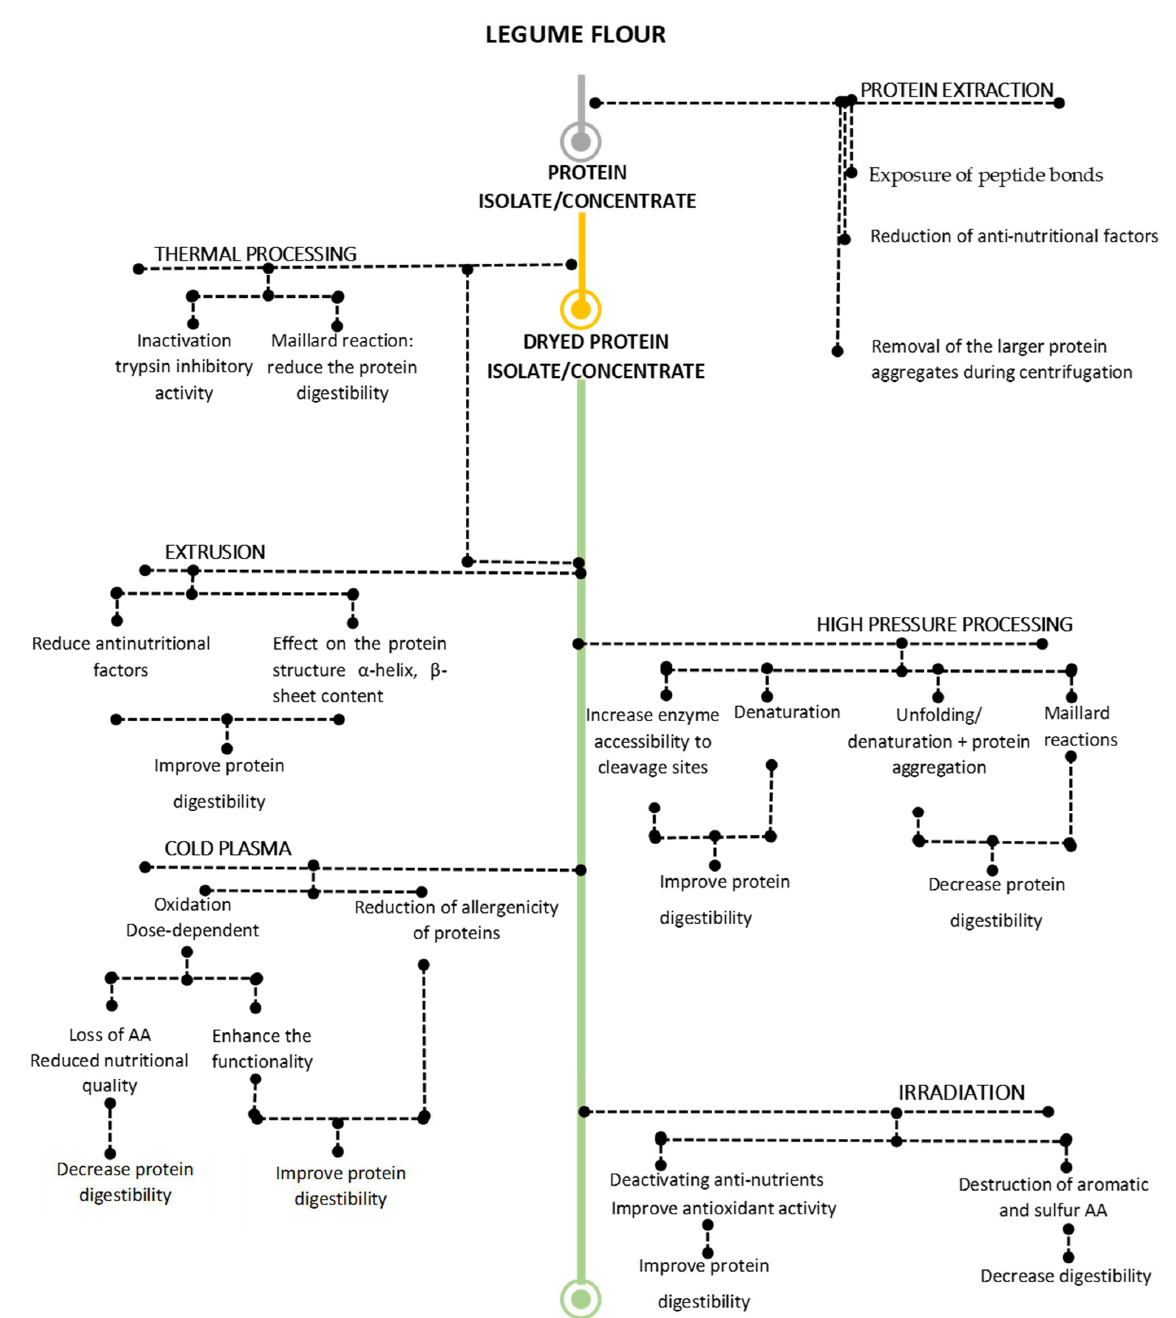
Figure 4. Effect of extraction and processing techniques on the digestibility of the protein iso- late/concentrate